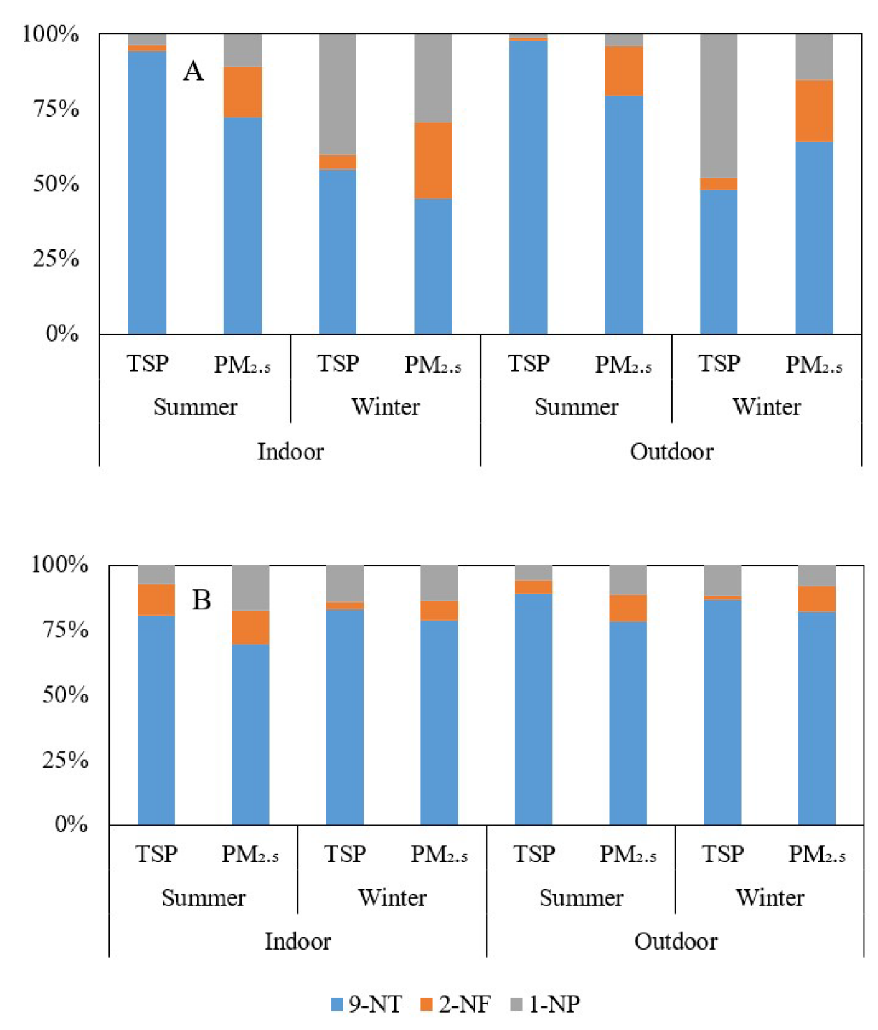
Figure 3. The composition of 9-NT, 2-NF, and 1-NP in PM 2.5 and TSP in 2019 (( A ): Haizhu District; ( B ): Huadu District).